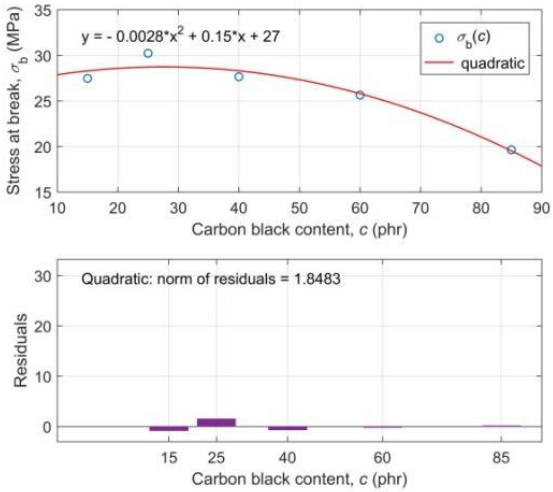
Figure 3. Regression analysis of the experimental dependence of the tensile stress-at-break σ b on the content of carbon black c in the rubber blend (top plot); Residuals of parametric fitting of the experimental data σ b ( c ) with the estimation of goodness-of-fit (lower plot).